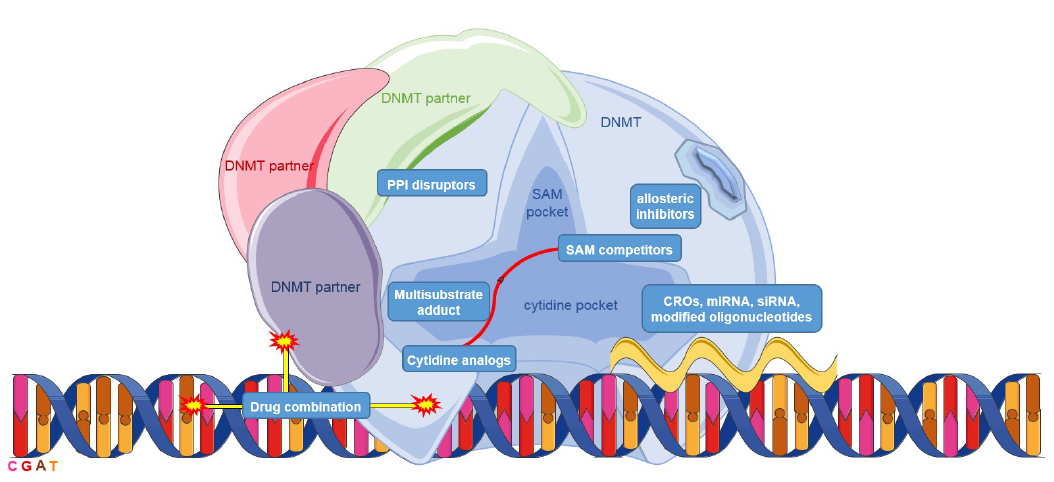
Figure 1. Schematic representation of different DNA methyltransferase (DNMT)-inhibition approaches. DNMT: DNA methyltransferase; PPI: protein–protein interaction; SAM: S -adenosyl-L-methionine; CRO: chimeric RNA oligonucleotides; miRNA: micro RNA; siRNA: small interfering RNA. 4 (cid:48) -Thio-2 (cid:48) -deoxycytidine (TdCyd) ( 6 ) is another cytosine analog in clinical trials for